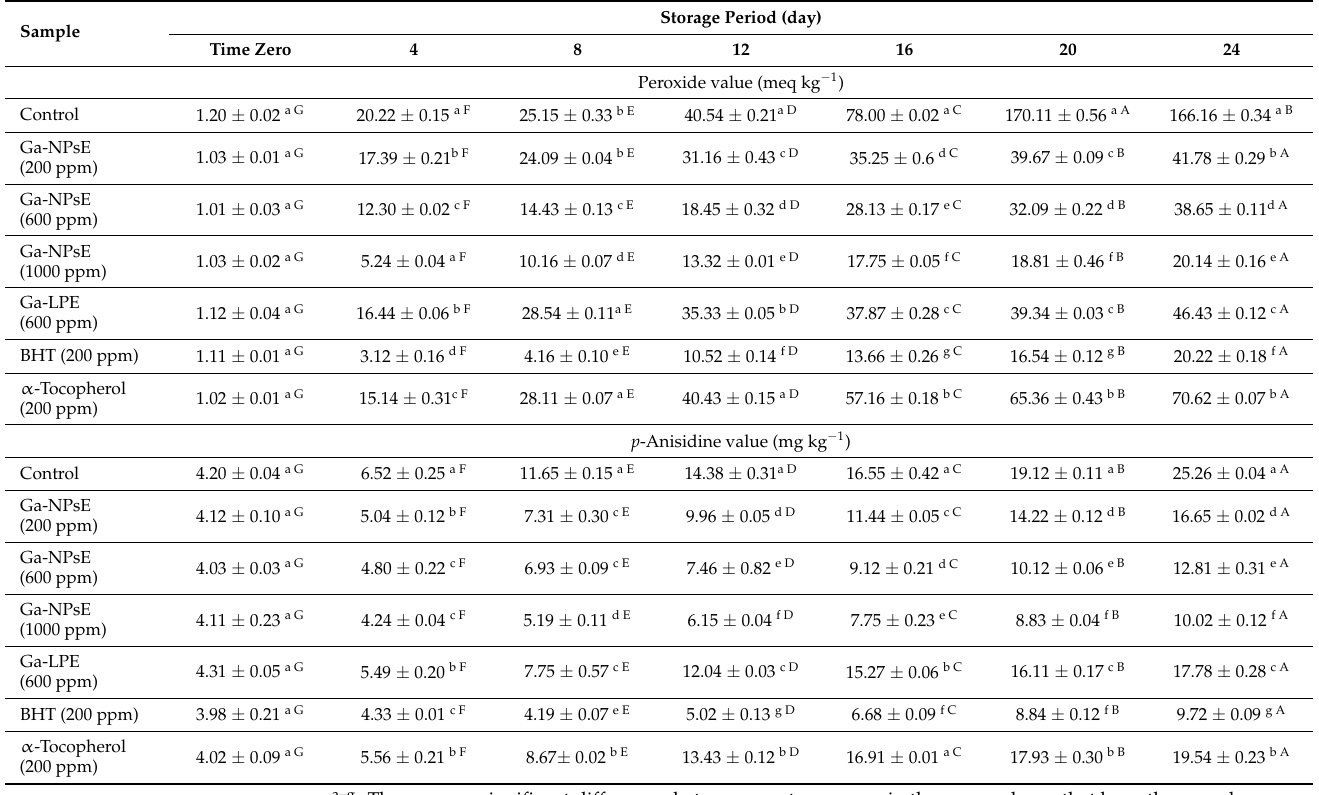
Table 2. Effect of garlic nanoparticle extracts on peroxide value and p -anisidine value of SFO during storage at 65 ◦ C (mean ± SD, n =